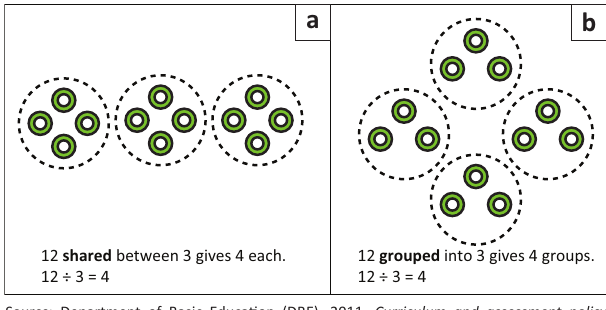
FIGURE 2: Suggested images that can be used to explain the differences between sharing and grouping.